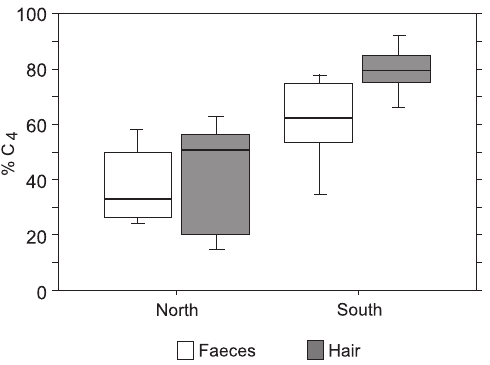
Fig. 2. Boxplot with the median, 25-75 %, and standard deviation of the dietary percentage of C 4 grass con- sumed by impala in the northern and southern regions of Kruger National Park. Note that both hair and faeces data agree that impala graze more in the